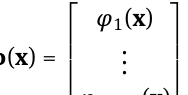
of equations as the number of nodes and the latter corre- sponds to the number of unknowns.